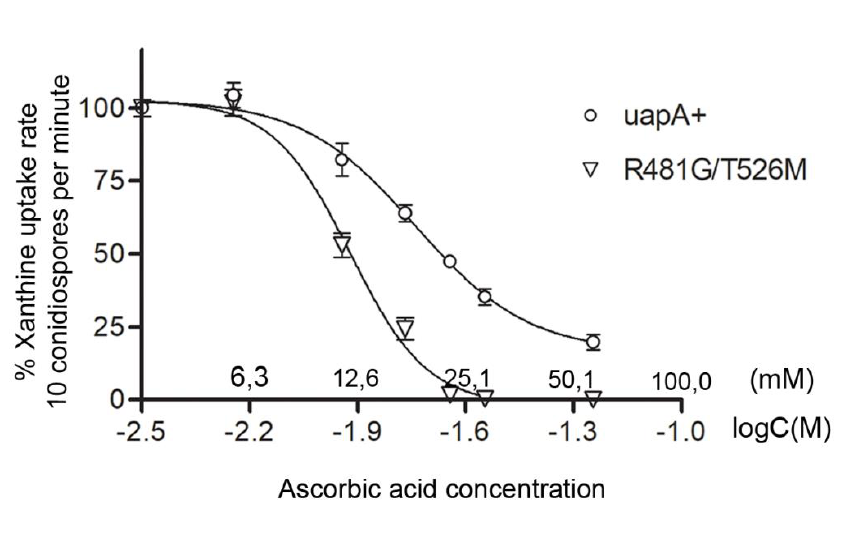
FIGURE 3: L-ascorbate inhibits UapA transport activity. The graph shows dose response curves of [ 3 H]-xanthine uptake rate in strains expressing ei- ther wild-type UapA or the isogenic mutant UapA-R481G/T526M, in the presence of increasing concentration of non-radiolabeled L-ascorbate (0-56 mM). In both cases, L-ascorbate inhibited UapA transport activity, with K i values estimated at 17 and 11 mM for UapA and UapA-R481G/T526M, respectively. Results are averages of three measurements for each concen- tration point. SD was < 18%. For de- tails of measurements and K i estima- tion see Materials and